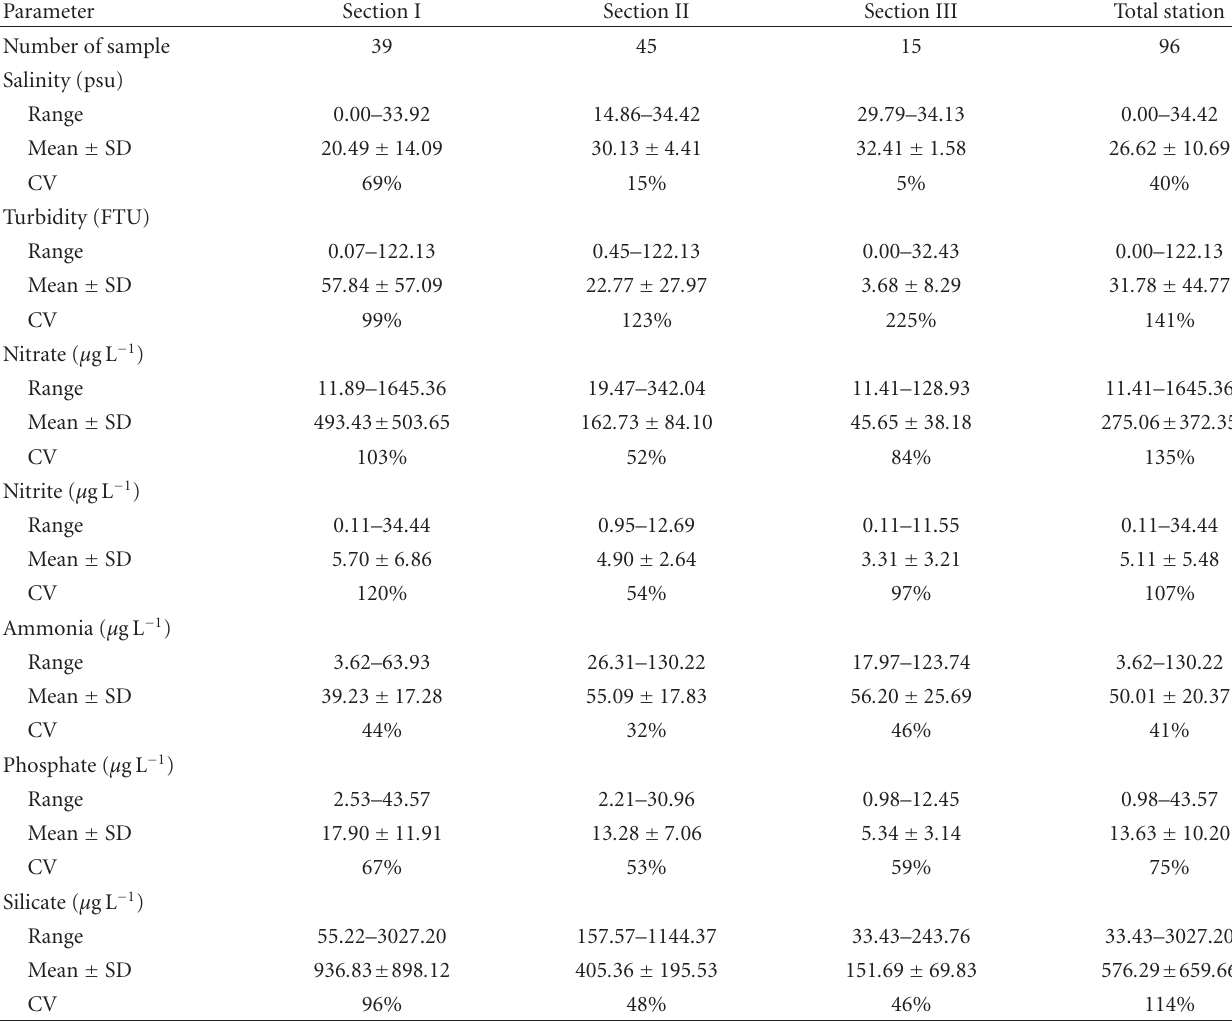
Table 1: List of the measured environmental parameters in the Changjiang estuary and its adjacent sea area in June 2006.